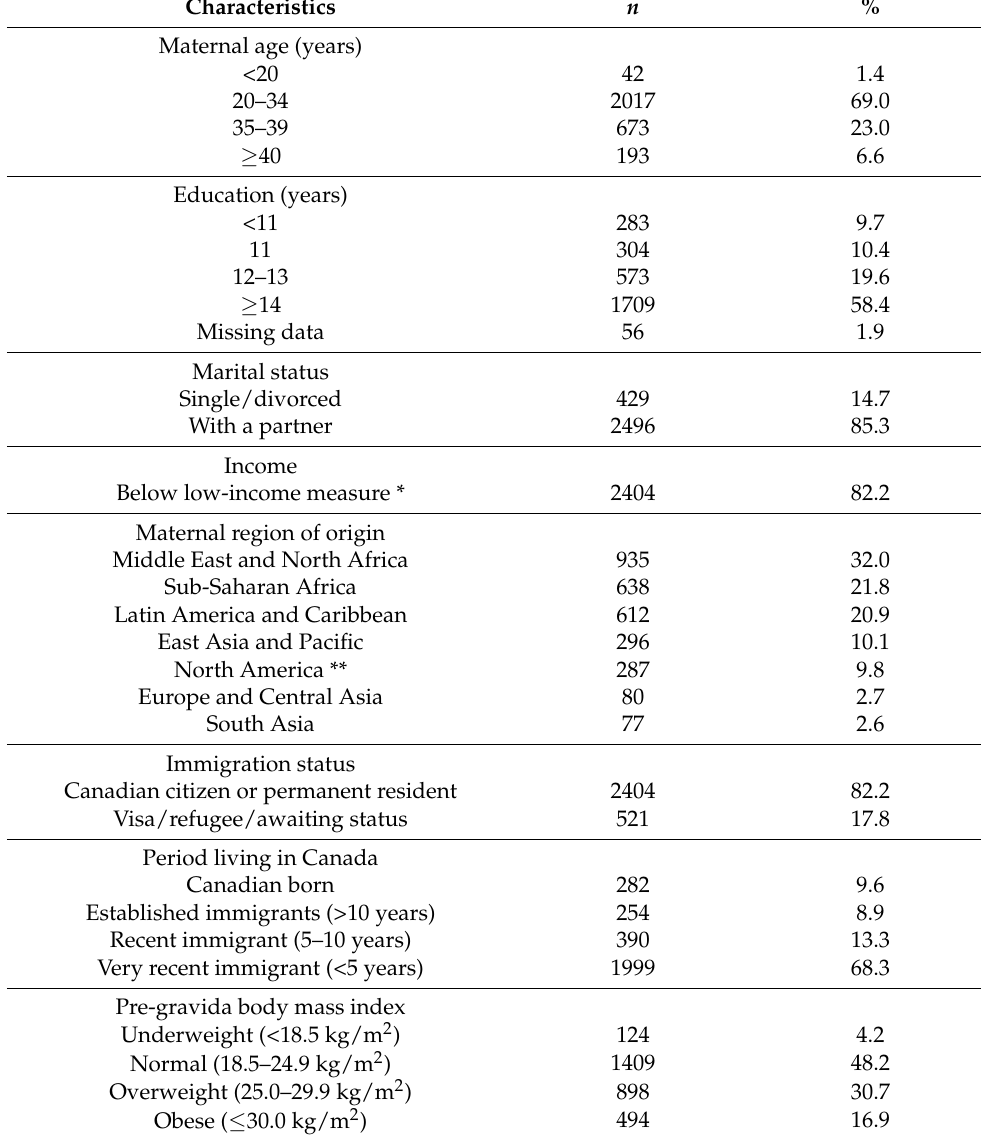
Table 1. Characteristics of the study population ( n =